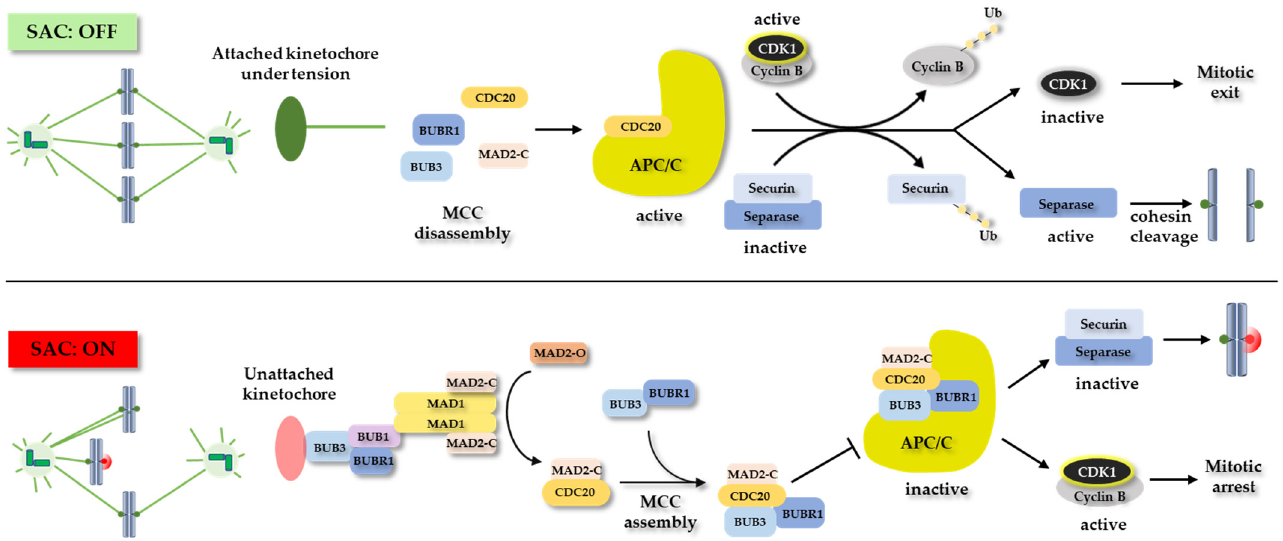
Figure 1. A molecular view of SAC signaling. Correct attachment of kinetochores to microtubules emanating from opposite spindle poles does not turn on the SAC (SAC: OFF). This results in MCC disassembly and activation of APC/C. Active APC/C contributes to degradation of cyclin B, which activates CDK1 and allows mitotic exit. At the same time, APC/C degrades securin, which inhibits separase. Activated separase cleaves the cohesin rings, allowing the separation of the sister chromatids. By contrast, unattached or incorrectly attached kinetochores activate the SAC (SAC: ON). This leads to formation of MCC, which binds to and inactivates APC/C. This prevents degradation of securin and cyclin B, leading to mitotic arrest.